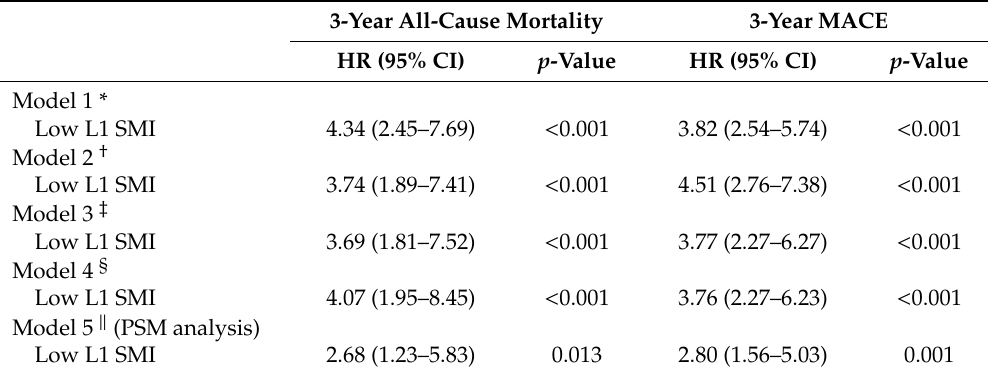
Table 3. Multivariate analysis of 3-year clinical outcomes.